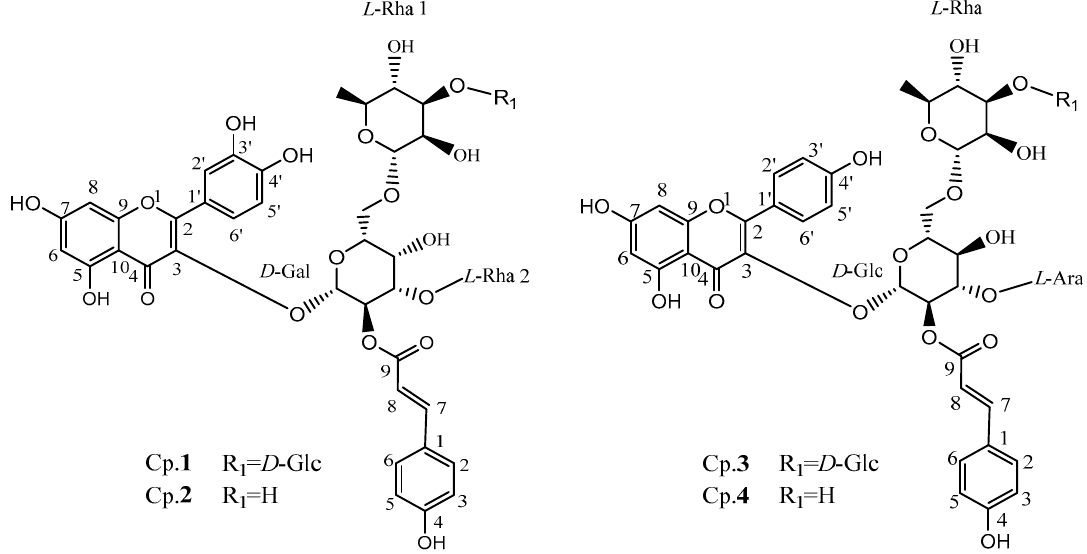
Figure 1. Chemical structures of acylglycosides flavones isolated from Fuzhuan brick tea. Compound 1 : The molecular formula was determined to be C 48 H 56 O 27 based on its [M+H] + ion at